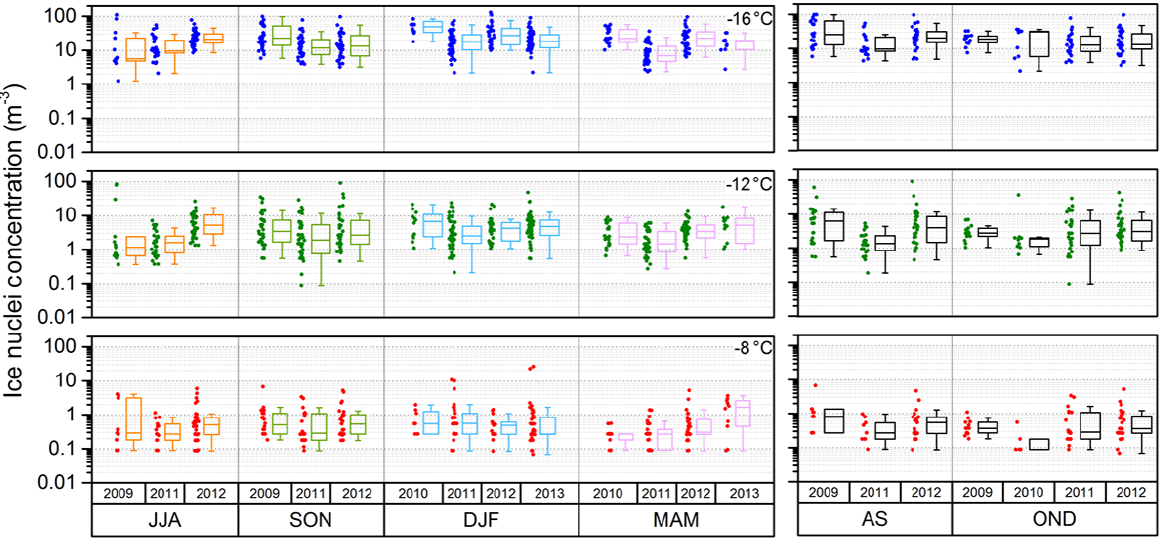
Figure B1. Seasonal variation in ice nuclei concentration separated for each year of measurement (JJA: June–August; SON: September– November; DJF: December–February; MAM: March–May). Box plots of the rainy season (AS: August–September) and the season of high biological productivity (OND: